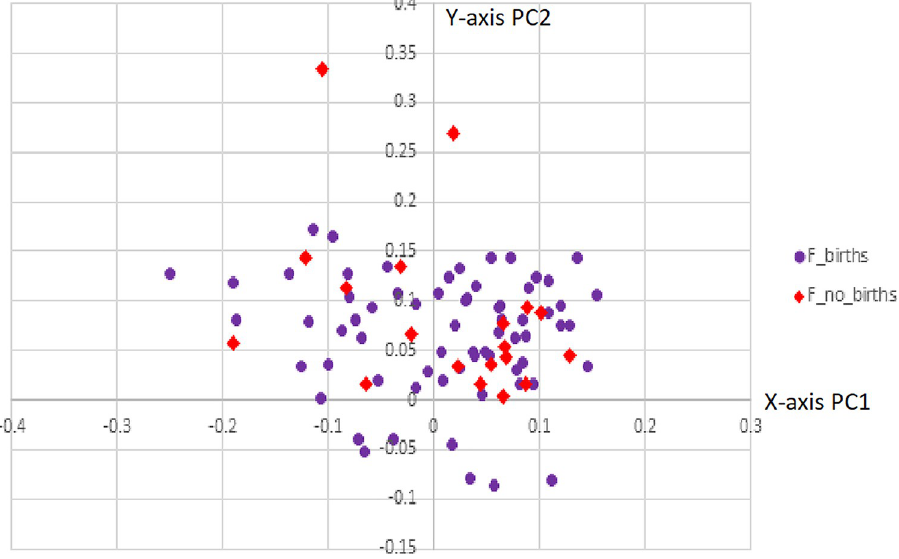
Fig 5. PCA parity scatter plot. PCA scatter plot displaying available data on parity of females (parous vs. non-parous).